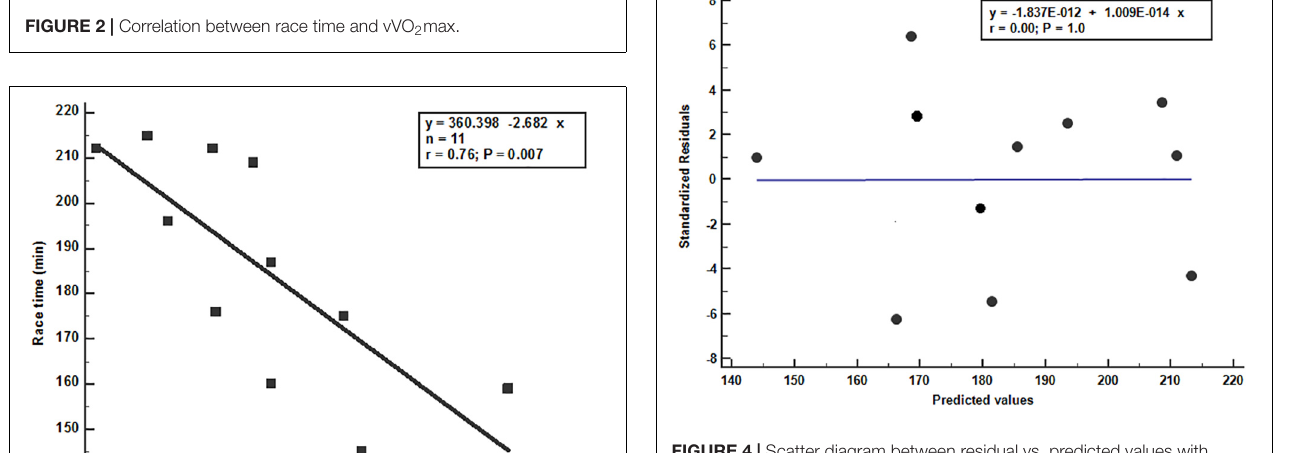
FIGURE 4 | Scatter diagram between residual vs. predicted values with regression